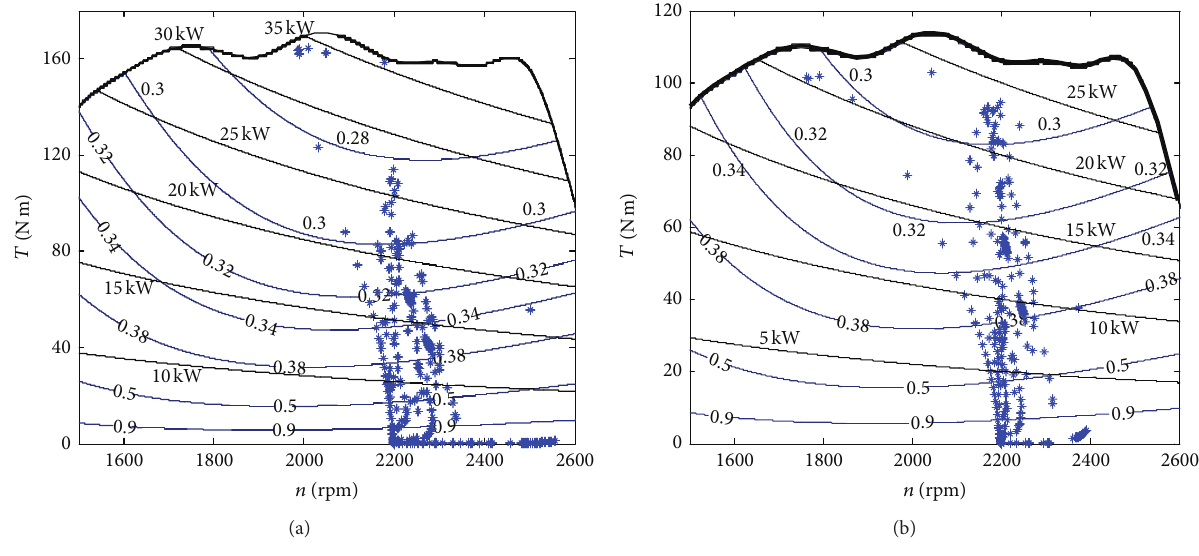
Figure 15: Engine operating point during cycle.